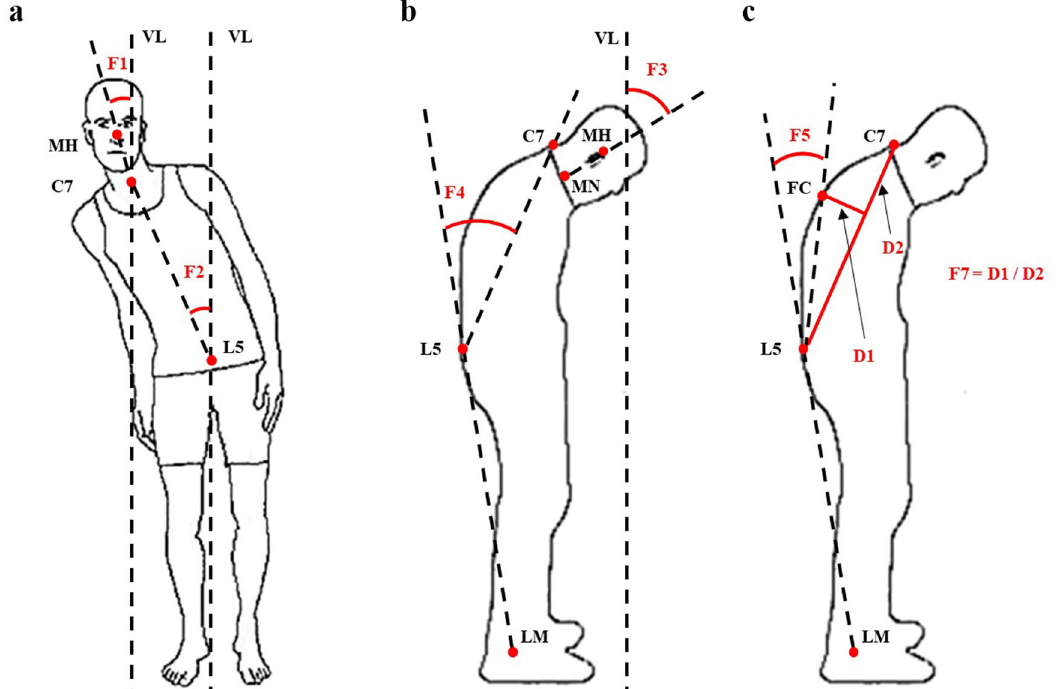
Fig. 1 Illustration of the six selected features F1, F2, F3, F4, F5, and F7 (modi fi ed from ref. 27 ). F1: lateral fl exion angle of head, the angle between the connecting line of MH and C7 on the coronal plane and VL ( a ); F2: lateral fl exion angle of trunk, the angle between the connecting line of C7 and L5 on the coronal plane and VL ( a ); F3: forward fl exion angle of head, the angle between the connecting line of MH and MN on the sagittal plane and VL ( b ); F4: total forward fl exion angle of trunk, the angle between the connecting line of L5 and LM and the connecting line of C7 and L5 on the sagittal plane ( b ); F5: forward fl exion angle of trunk at the waist, the angle between the connecting line of L5 and LM and the connecting line of FC and L5 on the sagittal plane ( c ); F7: F7 was normalized as “ D1/D2 ” with “ % ” as unit, to eliminate the effect of anthropometrical difference. D1 and D2 referred to the distance between FC and the connecting line of C7 and L5, and distance between C7 and L5 on the sagittal plane, respectively ( c ). MH the midpoint of head, MN the midpoint of neck, VL the vertical line of the ground, C7 the 7th cervical spinous process, L5 the 5th lumbar spinous process, LM lateral malleolus, FC vertebral fulcrum which indicates the most convex point of the